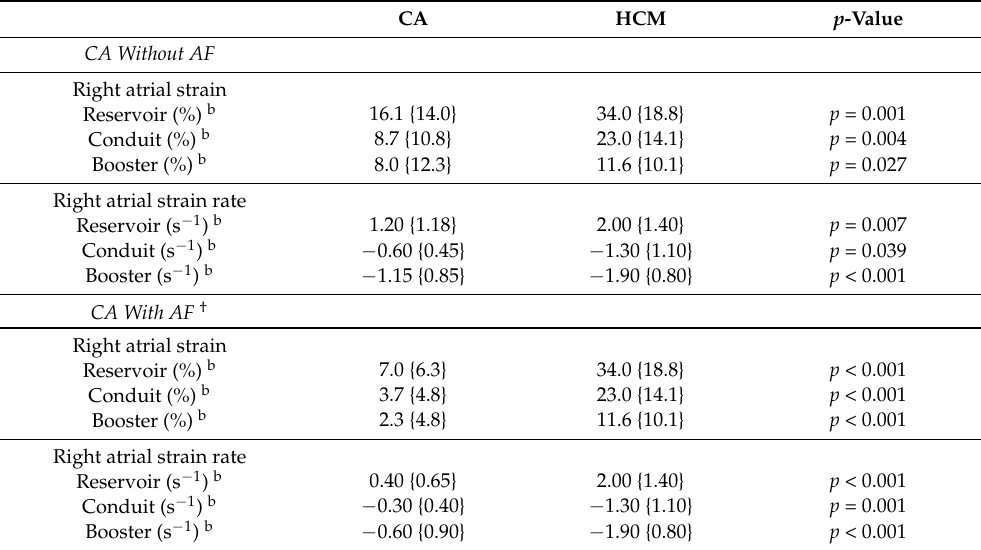
Table 4. Comparison of CA patients vs. HCM patients with and without atrial fibrillation and impact on right atrial global longitudinal